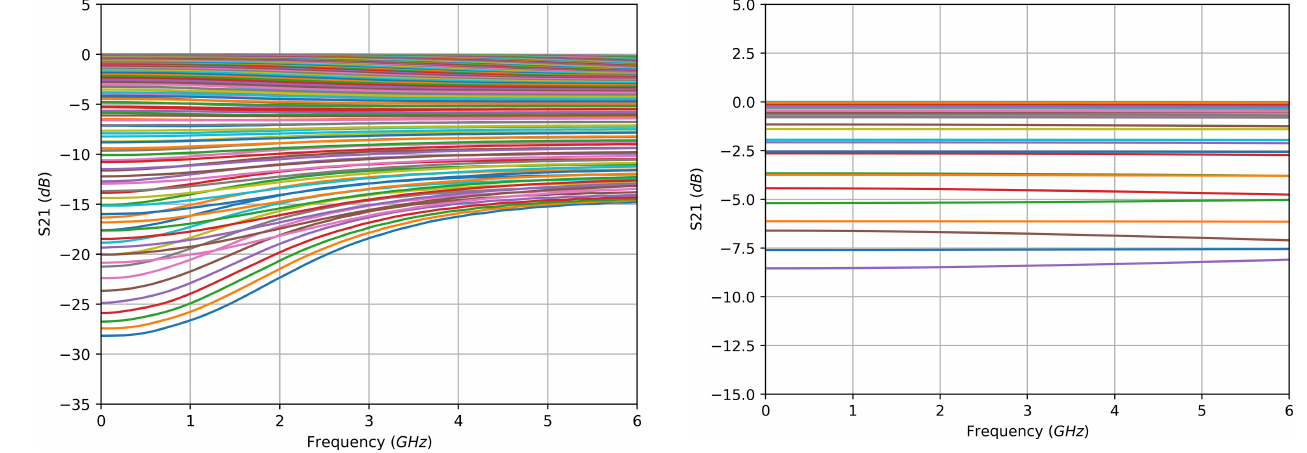
Figure 18. Analytically modelled amplitude for cFBG in reflection configuration.